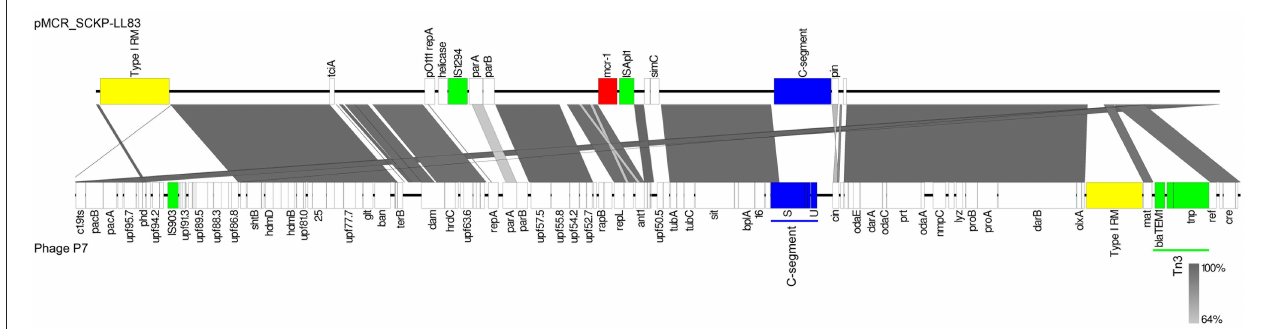
Frontiers in Microbiology | www.frontiersin.org